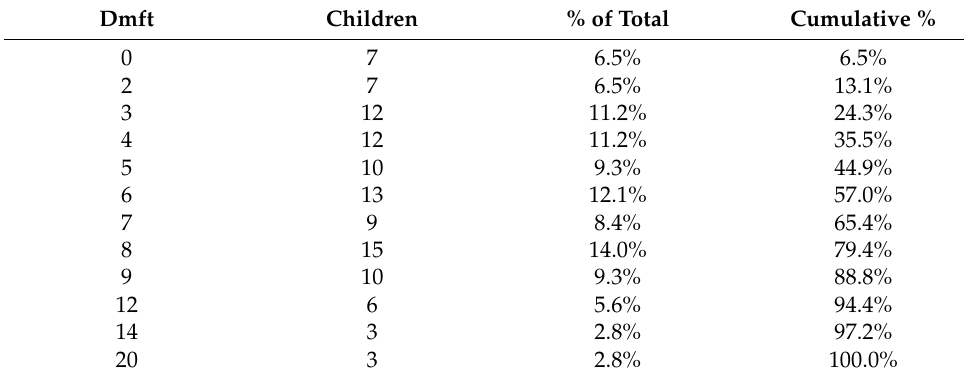
Table 5. Frequencies of dmft index.